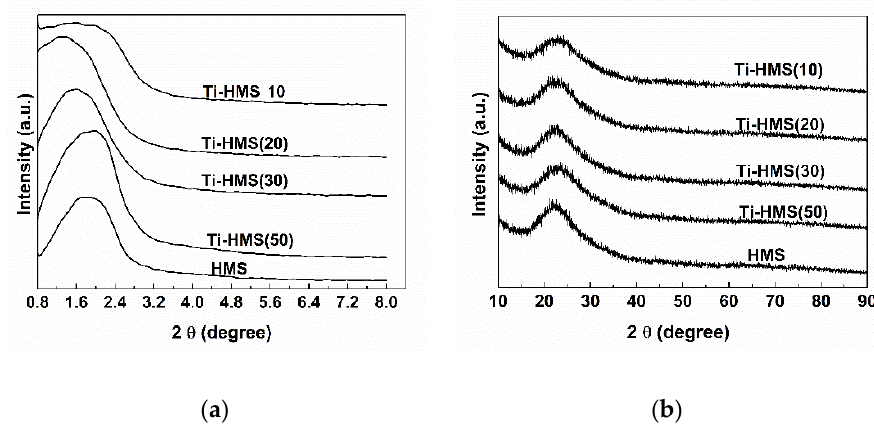
Figure 1. XRD patterns of HMS and Ti-HMS. ( a ) Low-angle. ( b ) Wide-angle.